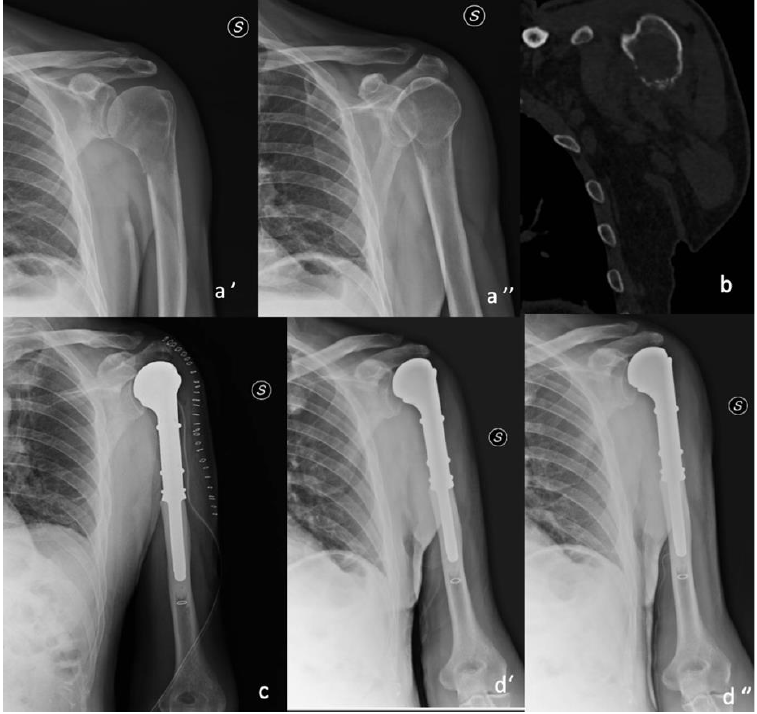
Figure 1. y.o. male affected by metastatic kidney tumor. Lateral approach resection was 10 cm. ( a’ , a’’ ) pre-op X-ray; ( b ) pre-op ct scan; ( c ) post-op X-ray; ( d’ , d’’ ) 6 months follow.